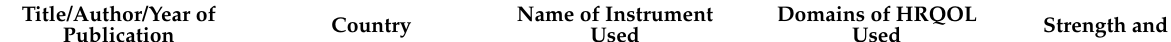
Table 1. List of selected publications and the different types of HRQOL measures